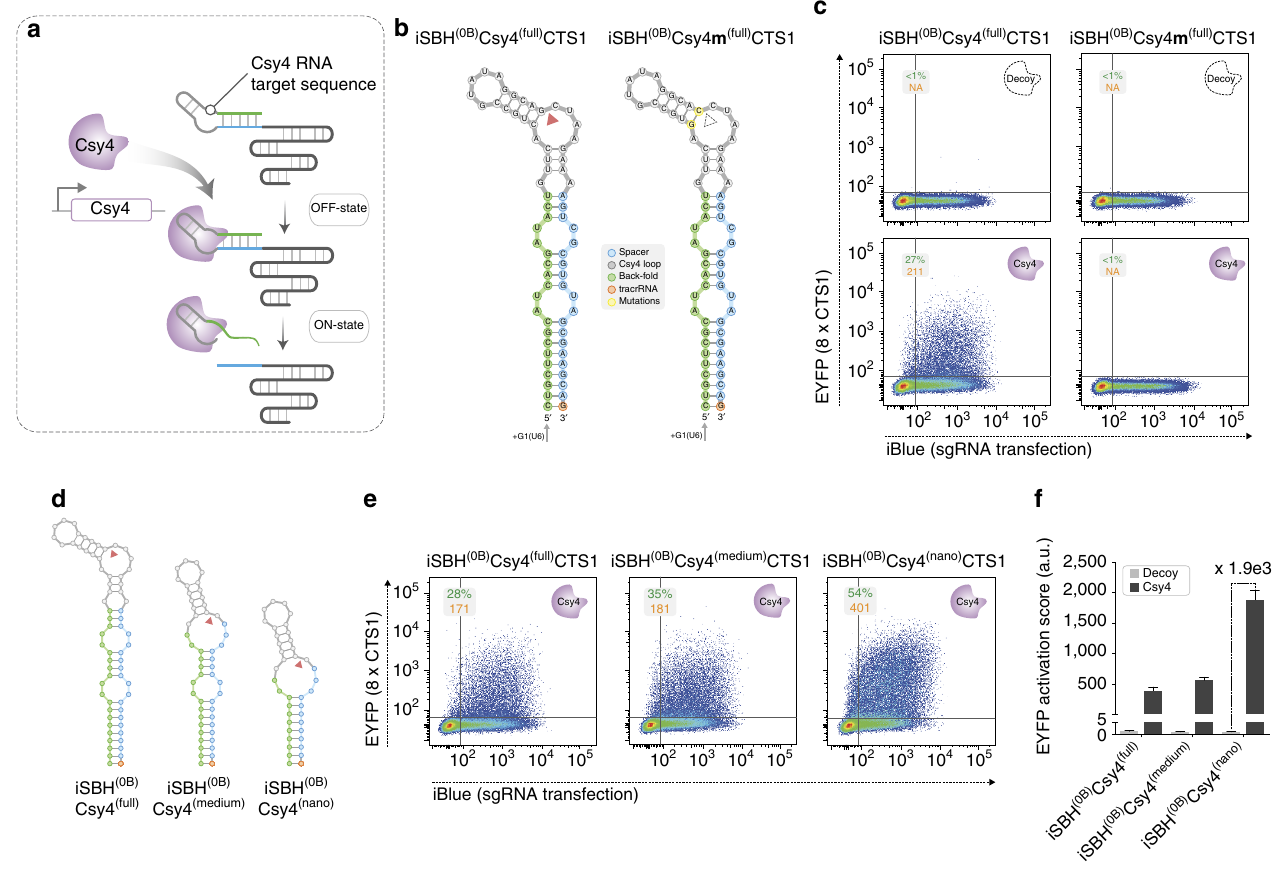
Figure 2 | Design and optimization of protein-responsive iSBH-sgRNAs. ( a ) Conceptual framework underlying conditional spacer release using genetically encoded inducers (endoribonucleases). Grafting the Csy4 RNA motif onto the SBH stem allows OFF- to ON-state transition in the presence of the CRISPR-associated endoribonuclease Csy4. ( b ) Sequence and RNA secondary structure of the Csy4-responsive iSBH (0B) Csy4 (full) CTS1 and corresponding control mutant variant iSBH (0B) Csy4 m (full) CTS1 (base pair change (yellow) renders the recognition sequence insensitive to Csy4 cleavage). Red arrow indicates Csy4 cleavage site. ( c ) Representative flow cytometry scatter plots (EYFP reporter fluorescence against iBlue sgRNA transfection) reveal complete silencing in the absence of inducer (decoy ¼ empty plasmid). Robust reporter activation observed in the presence of Csy4 is lost when mutating Csy4-iSBH. ( d – f ) Optimization of Csy4-iSBH designs. RNA secondary structures (CTS1 spacer; red arrow Csy4 cleavage site) ( d ) and representative CRISPR-TR assay flow cytometry scatter plots ( þ Csy4 ON-state) ( e ) for iSBH (0B) Csy4 full, medium and nano stems. Quantification of EYFP activation score (see Methods) using the three iSBH variants in the presence of a decoy plasmid or Csy4 inducer from three biological replicates ( n ¼ 3, mean ± s.d.; a.u., arbitrary units) ( f ). Flow cytometry plot insets display % of activated cells (double iBlue þ ve and EYFP þ ve , green) and median reporter fluorescence intensity for this population